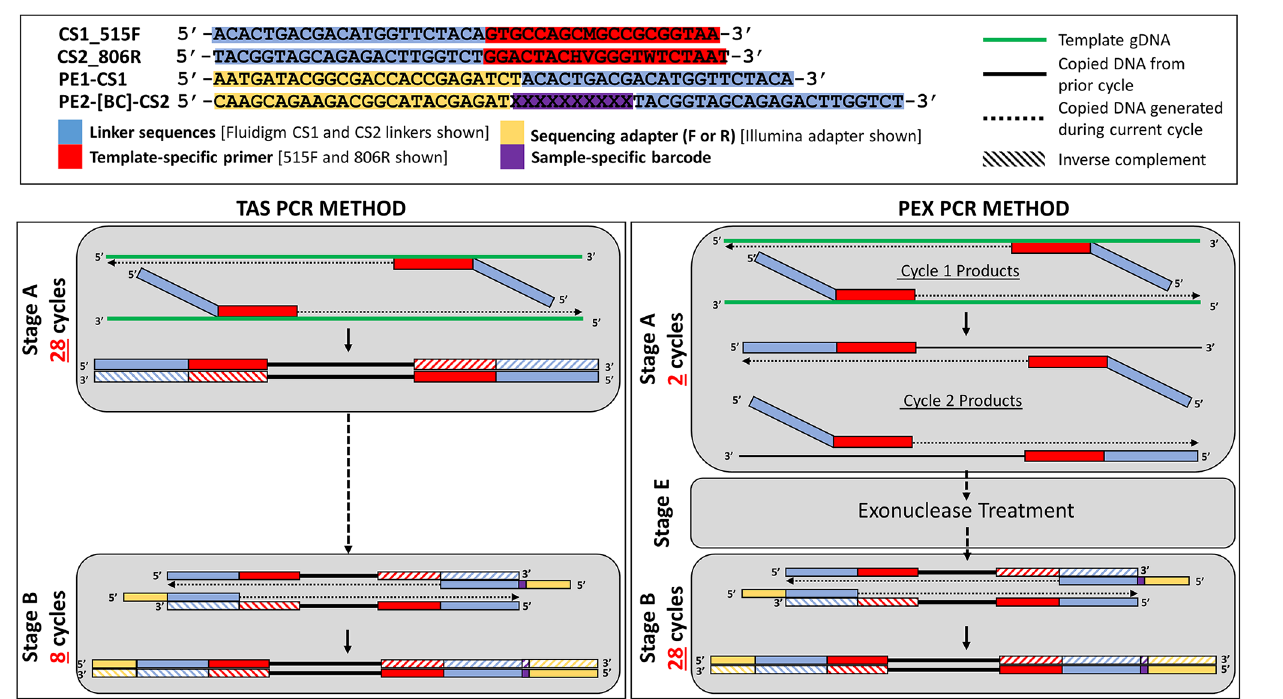
Fig 1. Schematic of Targeted amplicon sequencing (TAS) and Polymerase Exonuclease (PEX) PCR methods.